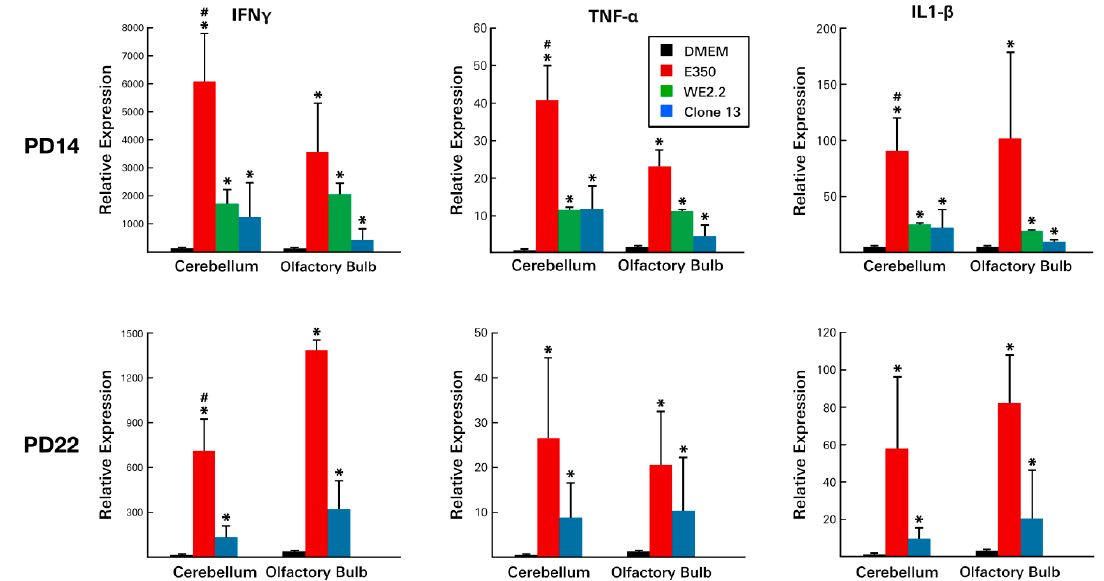
Figure 9. The different strains of LCMV induced different cytokine profiles. At PD14, all three viral strains provoked substantial increases in the expression of all three inflammatory cytokines. However, in both the cerebellum and the olfactory bulb, E350 provoked significantly greater cytokine responses than WE2.2 and Clone 13. At PD22, cytokine levels remained elevated, though not as high as at PD14. At PD22, E350 continued to induce substantially greater cytokine responses than Clone 13. *=Significantly different from DMEM control ( p < 0.05); # = significantly different from all other groups ( p < 0.05). Error bars represent standard error of the mean.